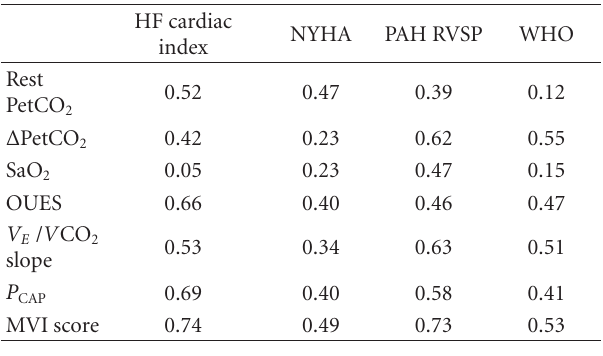
Table 6: Relationship of individual gas exchange measures with CI and RVSP in HF and PAH, respectively.